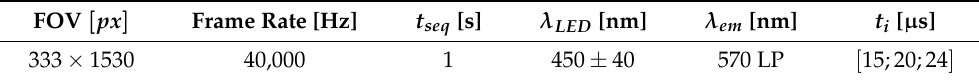
Table 2. Operating conditions of the imaging system for the high-speed TSP measurements. FOV [ px ]